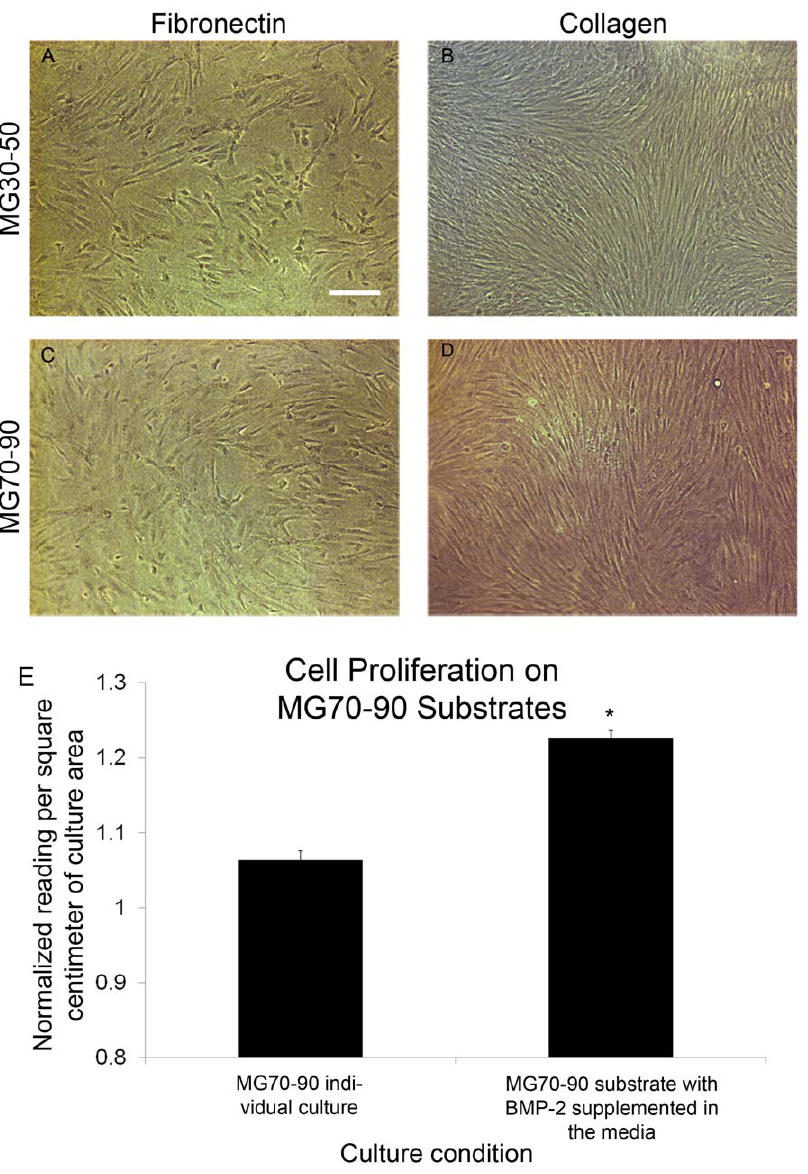
Figure 10. Arrest of osteogenic differentiation at day 14. (A–D) Individual culture of MG subsections supplemented with BMP-2 in the media no longer procured osteogenic plaques. Scale bar represents 100 m m. (E) The Alamar blue assay demonstrated an increase in cell proliferation on collagen functionalized osteogenic substrates (MG70–90) treated with BMP-2. * statistical difference (p , 0.05) between two conditions.